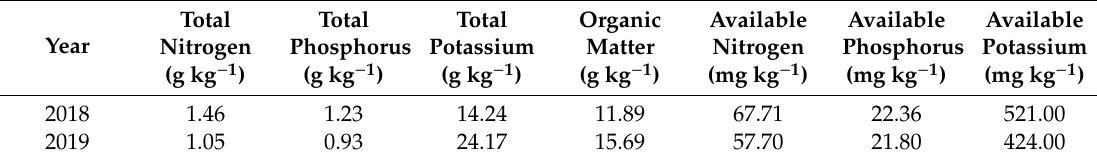
Table 1. Soil nutrition at the experimental site.